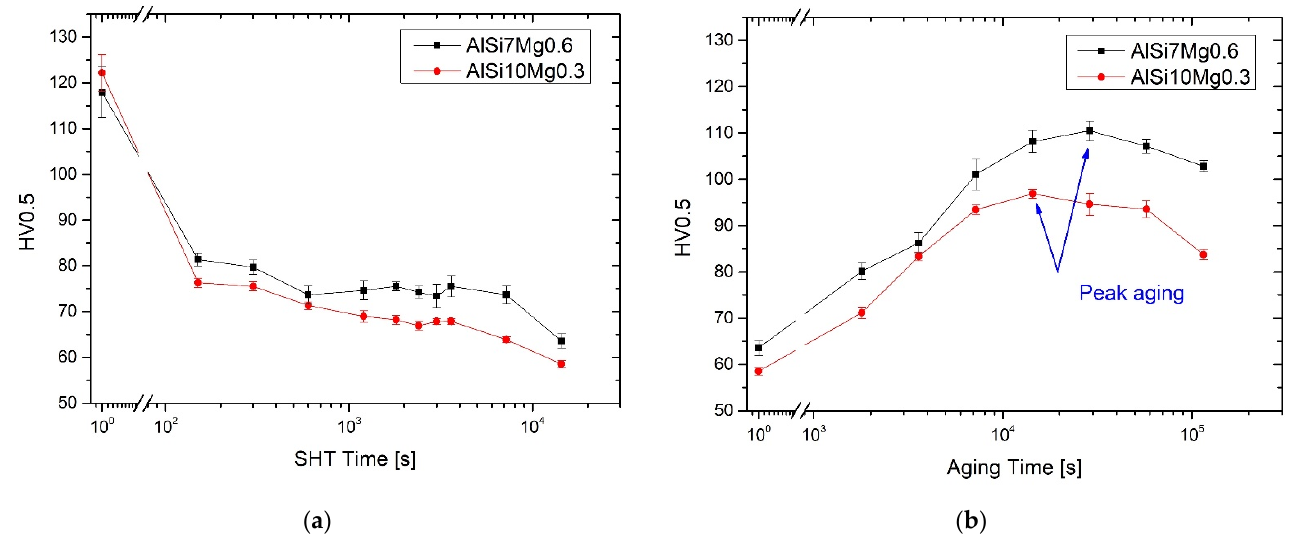
Figure 11. HV measurements on AlSi7Mg0.6 and AlSi10Mg0.3 samples after the SHT at 505 °C × 2.5 ′ –4 h ( a ) and after the artificial aging at 175 °C × 0–32 h ( b ). The as ‐ built conditions are considered at time equal to 1, and not to 0, because the time ‐ axes are in log scale.